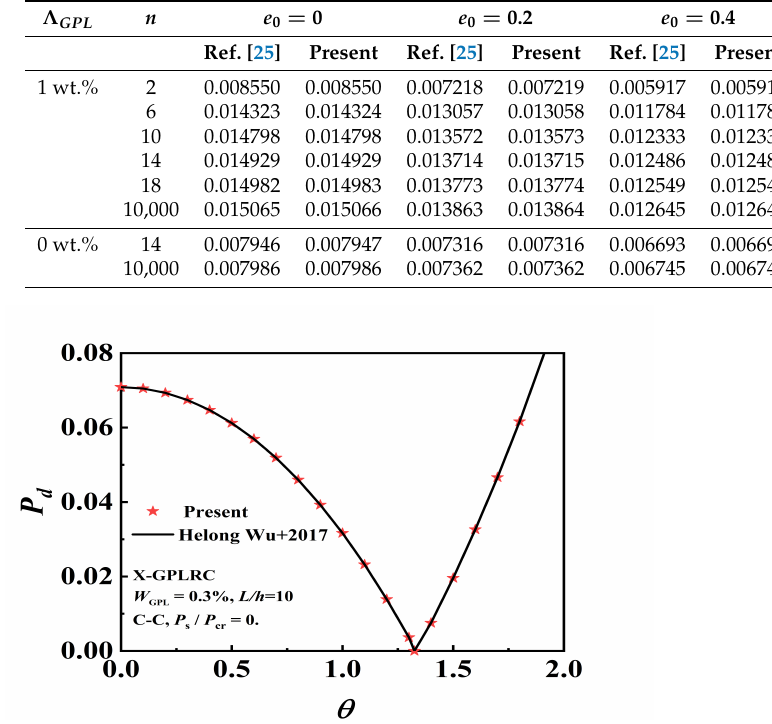
Figure 3. Comparison of the dynamic instability. Figure 4a,b separately show the convergence results of the critical buckling tempera- ture rise and the dimensionless natural frequency under various conditions. When N = 9, their values gradually approach a certain amount. Tables 3 and 4 present the effect of the porosity coefficient e 0 and the total number of layers n on the critical buckling temperature rise and dimensionless natural frequency by DQM and the two-step perturbation method (TSPM). It turns out that the error between them is within 0.1%, and the accuracy and efficiency of the calculation results are verified again. Suppose n = 1000 is a continuous beam; it is found that a relative difference between n = 14 and n = 1000 is less than 1.5%. Considering the manufacturing process and manufacturing costs, n = 14 and N = 9 are used in the following calculation. In addition, when n = 14 and N = 9, the results show the natural frequency and critical buckling temperature rise are both increasing as e 0